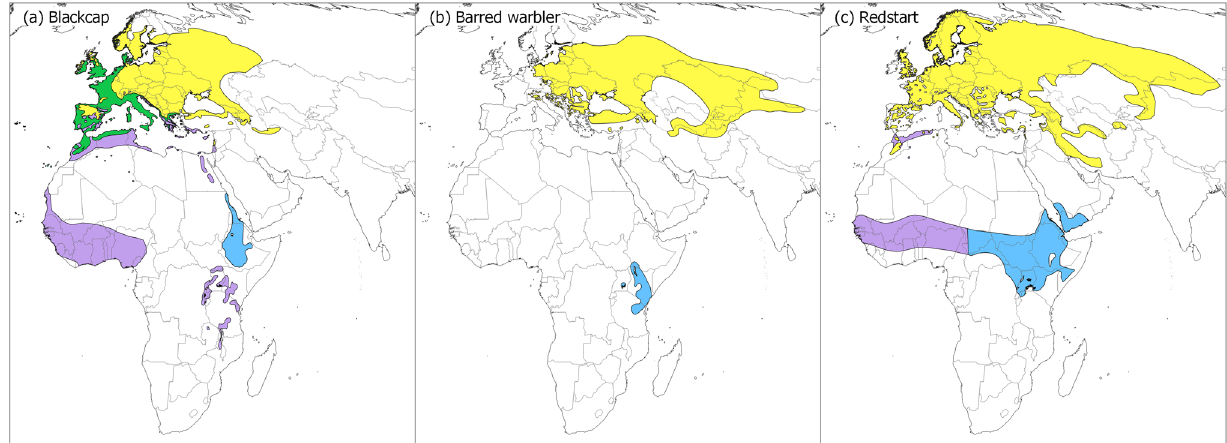
Figure 1. Distribution maps of the study species along the Eastern-Mediterranean flyway. ( a ) Eurasian blackcap ( Sylvia atricapilla) , ( b ) Barred warbler ( Sylvia nisoria ) and ( c ) Common redstart ( Phoenicurus Phoenicurus ). Yellow depicts breeding ranges; green depicts areas were population stay the entire year; blue depicts presumed non-breeding eastern distribution ranges, where migrants that stopover in Israel are likely to spend the non- breeding season, and purple depicts the western non-breeding distribution. Maps were created using qgis 3.6.0 (qgis 2018, http://qgis.osgeo .org), based on GIS data downloaded from BirdLife International data zone (http:// www.birdl ife.org/). The non-breeding areas (blue) that were used to calculate Enhanced Vegetation Index (EVI) for the species-specific non-breeding range were selected using qgis, based on the parameter “season” of the attribute table of the